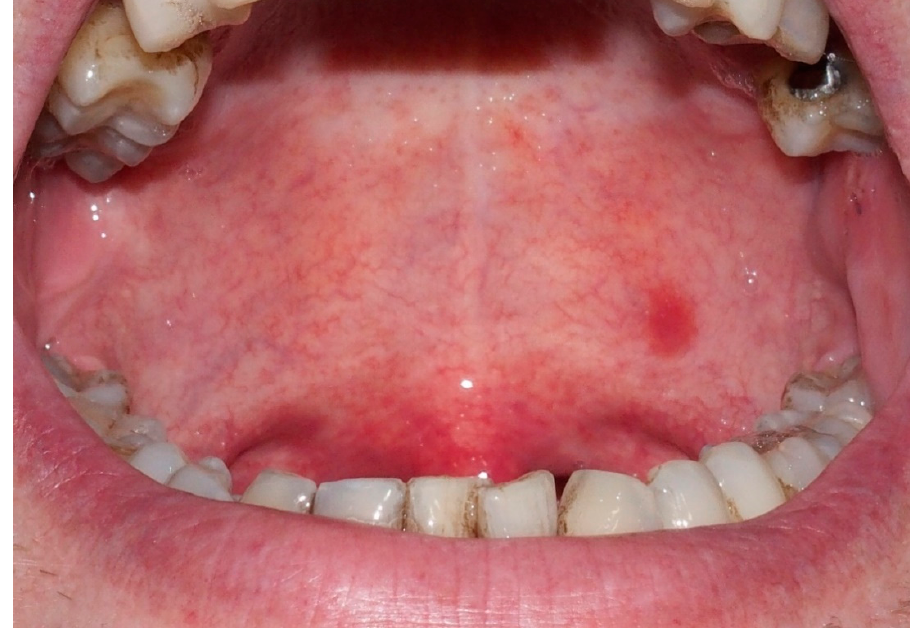
Figure 1. Erythroplastic lesion 8 × 4 mm in size located on the posterior third of the soft palate, left side next to the midline.